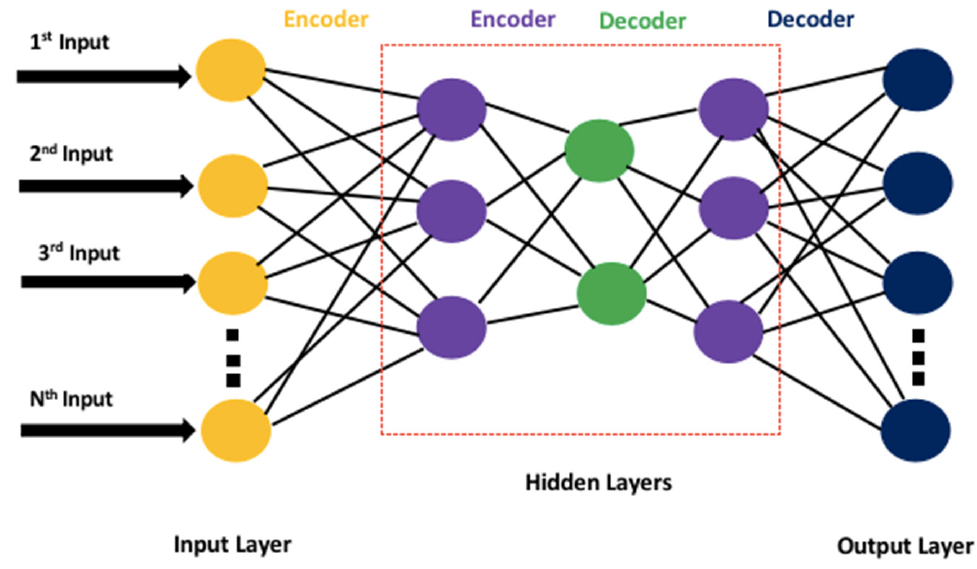
Figure 2. A schematic diagram of stacked autoencoder-based deep neural network .